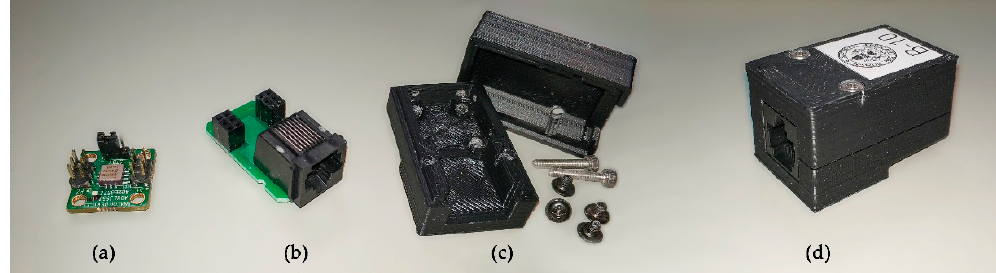
Figure 2. ( a ) ADXL355 accelerometer ( b ) adaptor board ( c ) 3D printed box ( d ) sensor assembled.